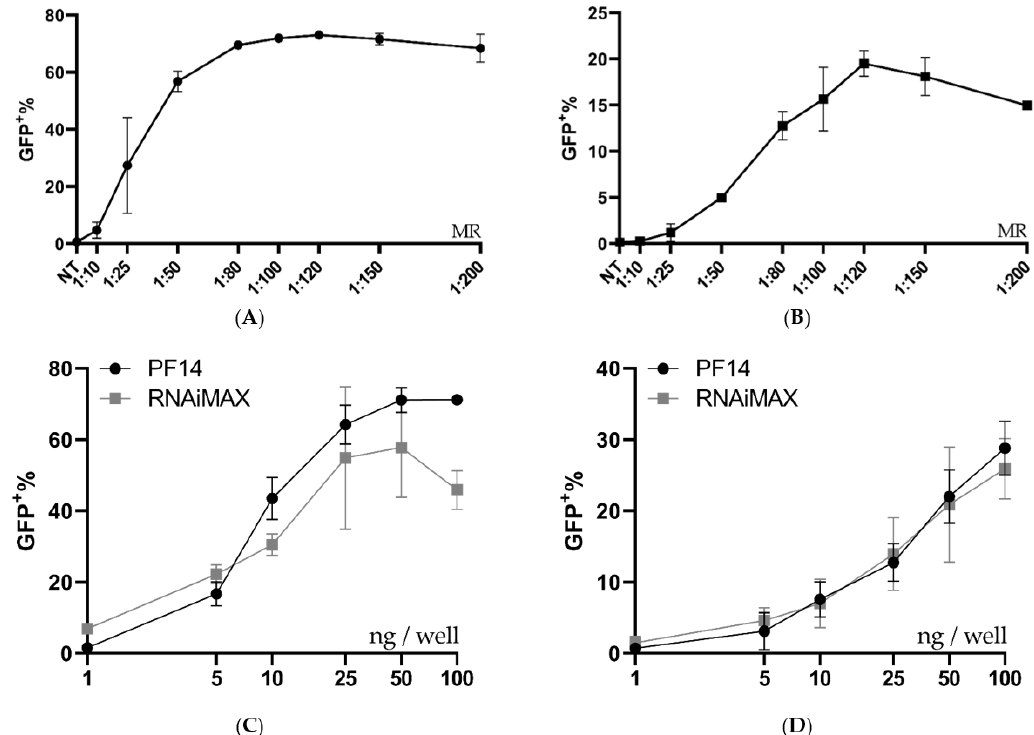
Figure 6. Ratio and dose testing in MDA-MB-231 SL and MCF-7 SL. ( A , B ) Ratio optimization of Cas9 RNP-PF14 (50 ng Cas9/well, formulated in DMEM/PVA-PEG (2.5 w/v %)) given to MDA SL and MCF SL cells. Means of n = 2. ( C , D ) Dose titration of RNP-PF14 (MR 1:150 RNP to PF14 formulated in DMEM/PVA-PEG (2.5 w/v %)) and RNAiMAX on ( C ) MDA SL and ( D ) MCF SL cells, respectively. Linear y -axis against log 10 x -axis. n = 3 for PF14-RNP and n = 2 for